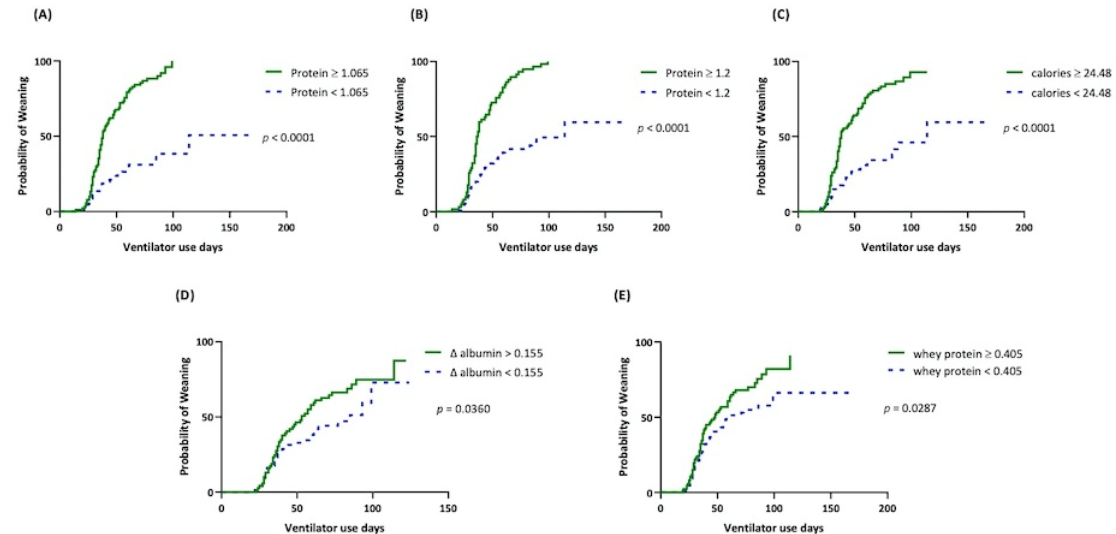
Figure 3. Kaplan–Meier survival curve of weaning outcomes with different nutritional parameters. ( A ) Daily protein intake, g/kg/day; ( B ) daily protein intake, g/kg/day; ( C ) daily calorie intake, kcal/kg/day; ( D ) ∆ albumin, difference between the 4th week and baseline serum albumin levels, g/dL; ( E ) daily whey protein intake, g/kg/day. Daily protein intake, daily caloric intake, ∆ albumin, and daily whey protein intake had no correlation with survival ( p = 0.3155, p = 0.7411, p = 0.3830, p = 0.4118, p = 0.5673, respectively, Figure 4, Table 3). BMI and tracheostomy were negatively correlated